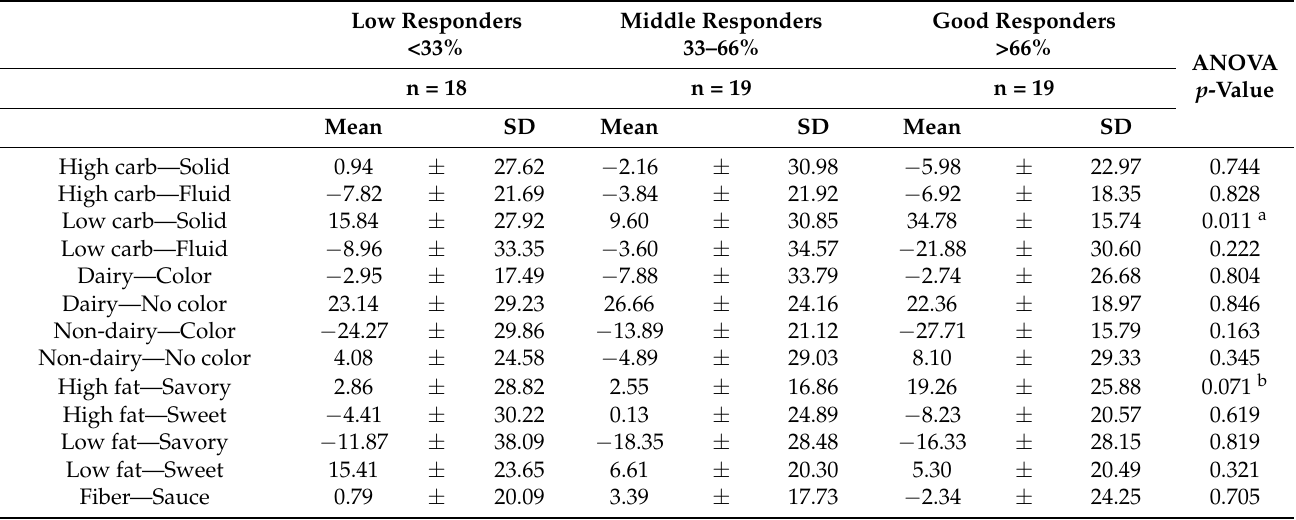
Table 5. Relationship between implicit wanting for foods regarding percentage of total weight loss tercile